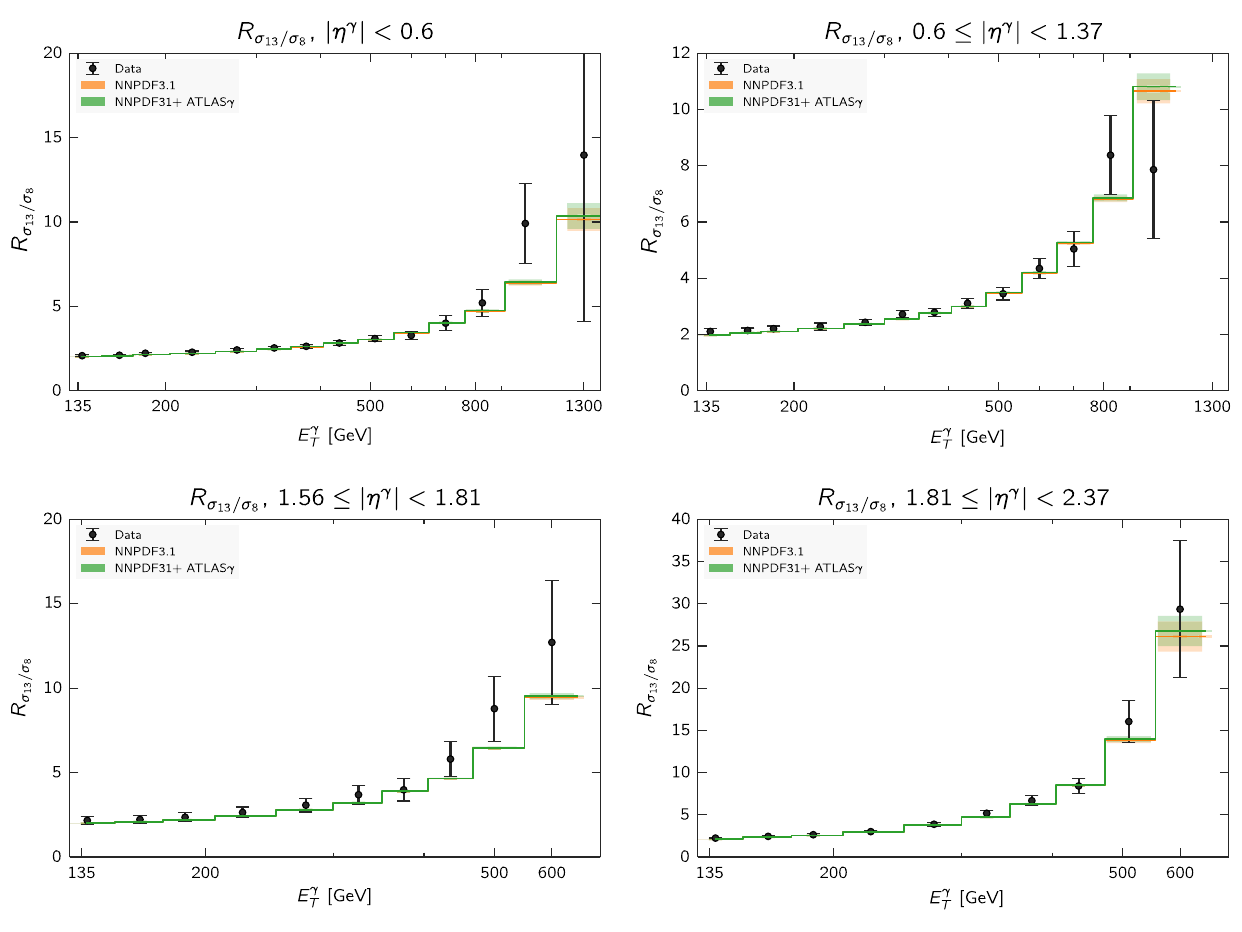
Fig. 12 Same as in Fig. 11 without normalizing to the experimental data Table 8 Same as Table 1 for the ratio of cross-sections between 13 and 8 TeV, Eq.